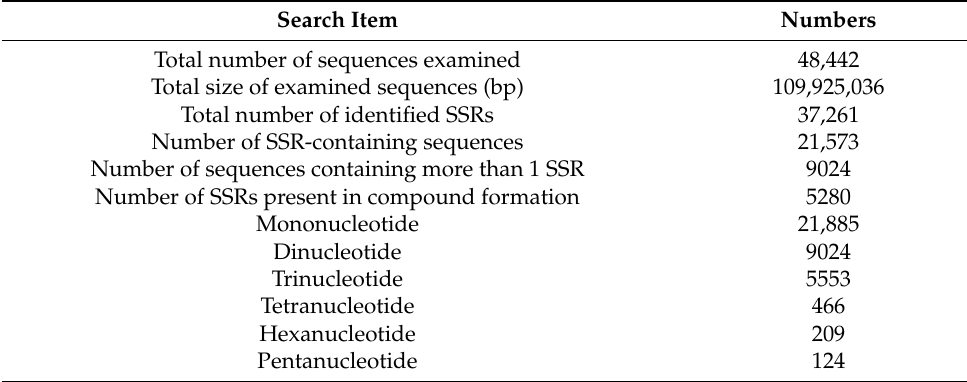
Table 1. SSRs obtained from